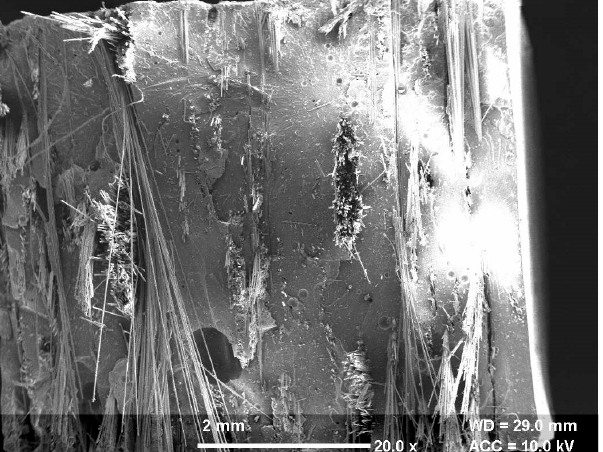
Figure 2. SEM of a cut sectional view of a polymer matric composite (PMC).